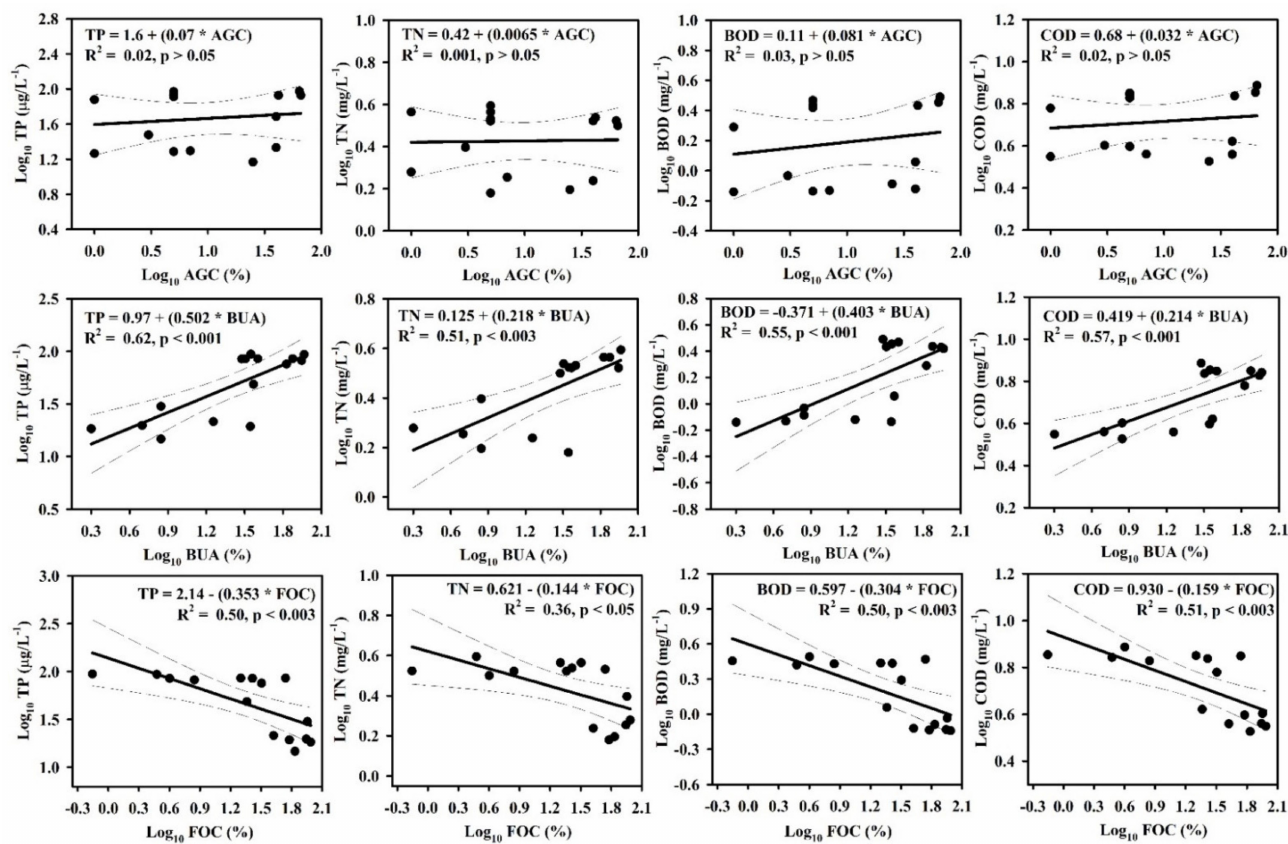
Figure 3. Relationships of LULC with water quality variables (AGC, agricultural coverage; BUA, built-up area coverage; FOC, forest coverage; TP, total phosphorus; TN, total nitrogen; BOD, biological oxygen demand; COD, chemical oxygen